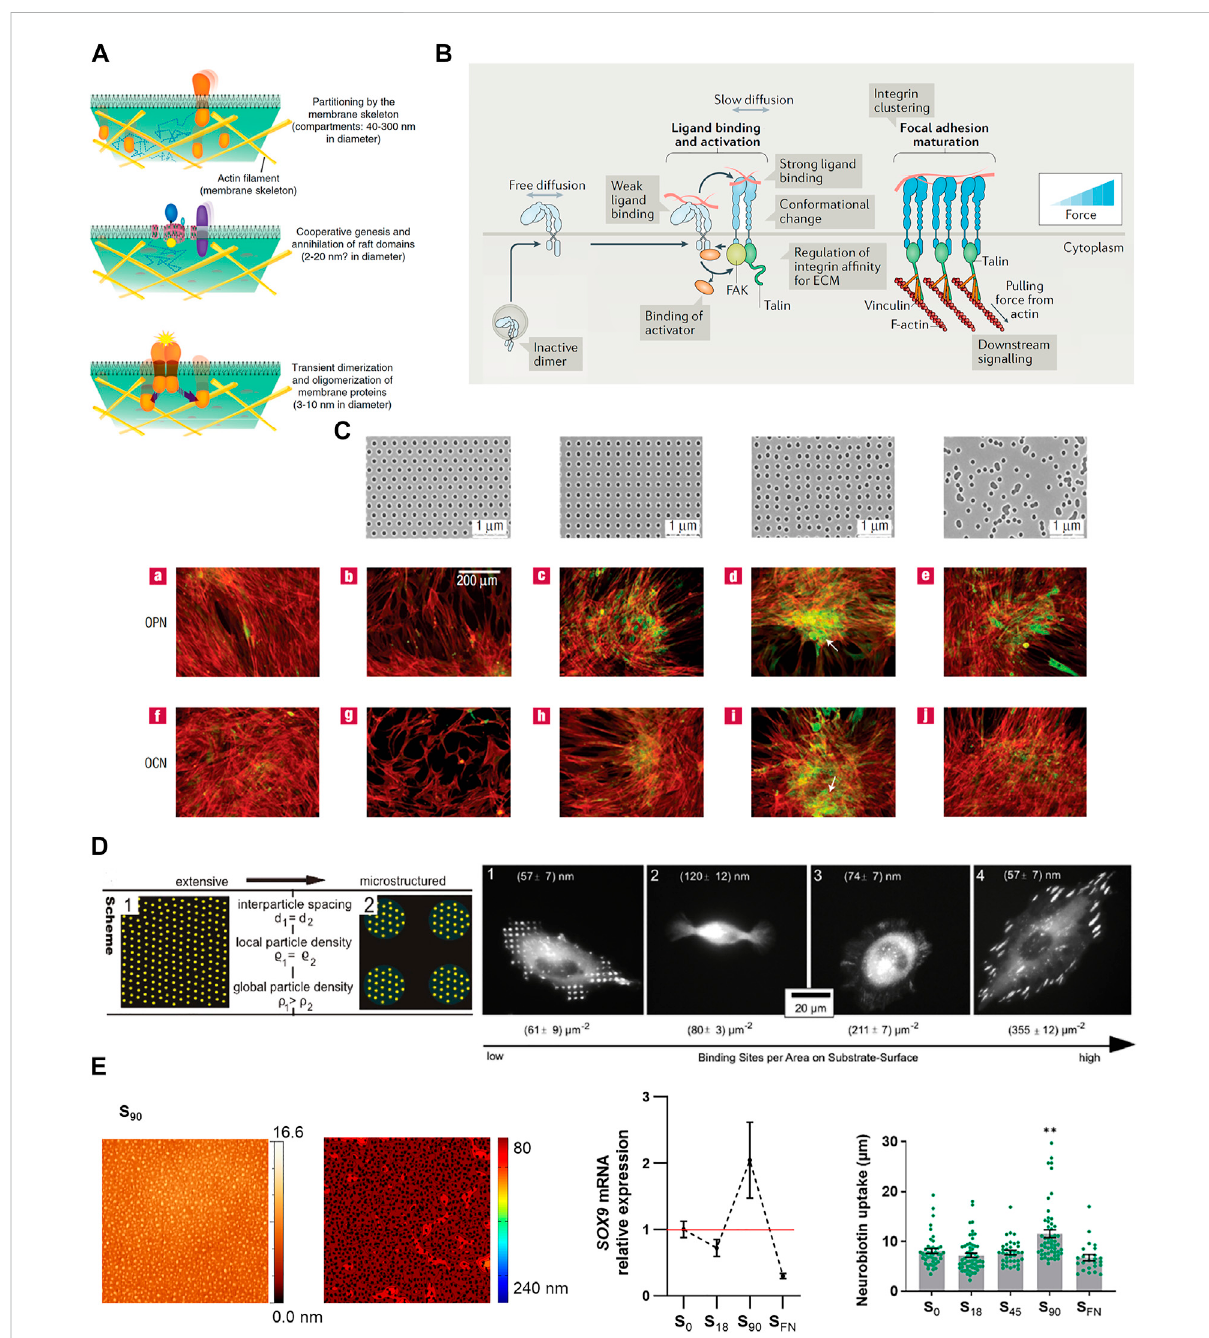
FIGURE 1 (A) Hierarchical organization of cell membrane compartments. Reprinted with permission from Kusumi et al., 2011. Copyright 2011 Elsevier. (B) Receptor nanoclustering: Ligand-mediated integrin clustering initiates the recruitment of adaptor proteins at FAs, leading to cytoskeleton engagement, force transmission and downstream signaling activation. Adapted with permission from Kechagiaet al., 2019. Copyright 2019 Springer Nature. (C) Osteoprogenitor differentiation (osteopontin (OCP) and osteocalcin (OCN) expression, and bone nodule formation (white arrows)) on nanotopographies with different levels of disorder, fabricated by EBL. Reprinted with permission from Dalby et al., 2007b. Copyright 2007SpringerNature. (D) BCMLcombinedwithphotolithographywereusedtocreatemicro-andnanopatternedsurfacesofthecelladhesiveligand cyclic-(RGDfK). The development of stable FAs, number, size and adhesion strength is more in fl uenced by local than global ligand density. Adapted with permission from Deeg et al., 2011. Copyright 2011 American Chemical Society. (E) The nanopatterning of RGD functionalized